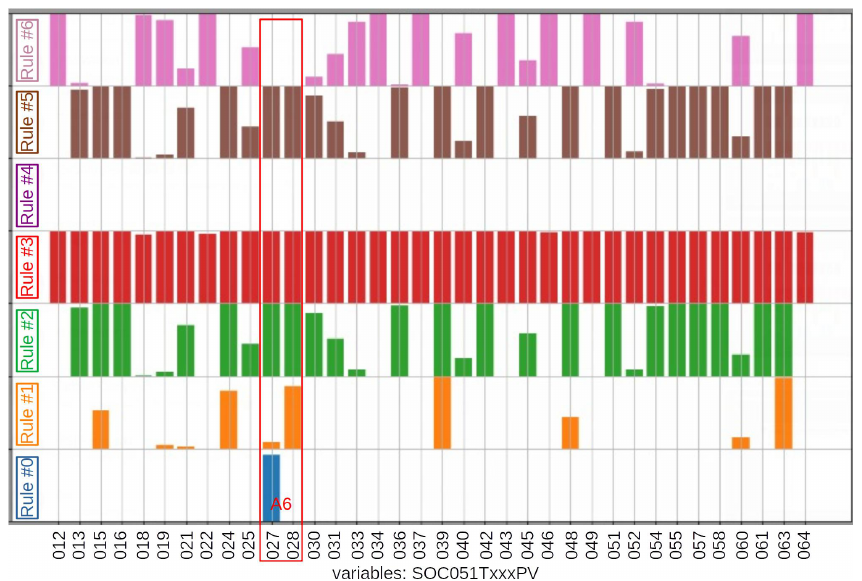
Figure 8. Bar graph of the cylinders subsystem during time window #1 (between 03:57 and